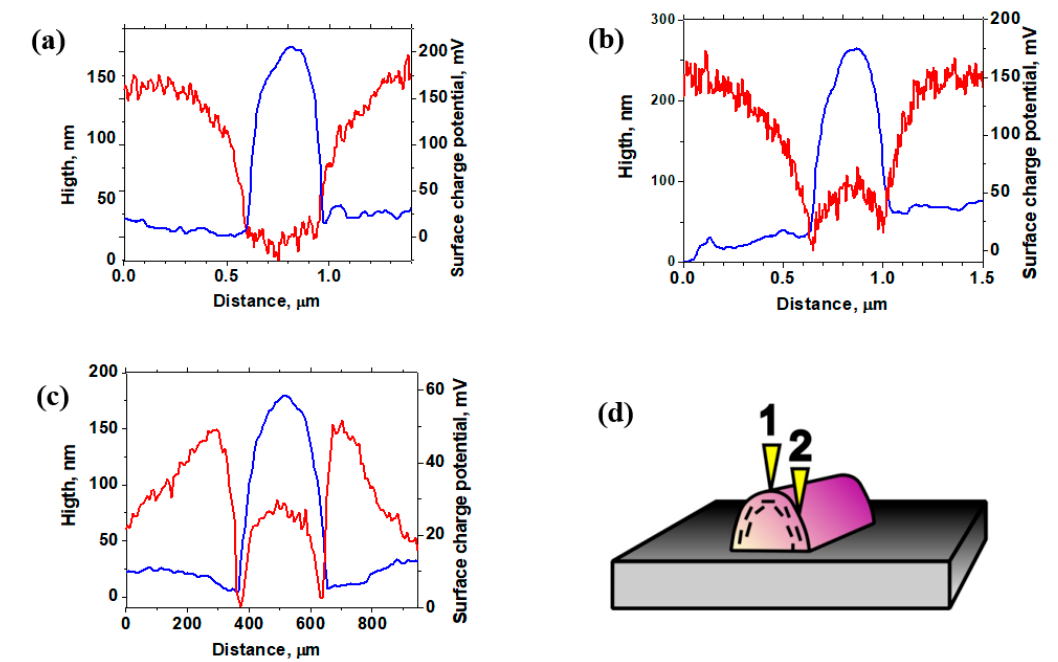
Figure 5. ( a – c ) Profile of the KPFM images (surface potential); ( d ) Schematic illustration of KPFM of P(VDF-TrFE) / Graphene oxide composite fibers. ( a ) 0% GO; ( b ) 5% GO; ( c ) 20% GO.